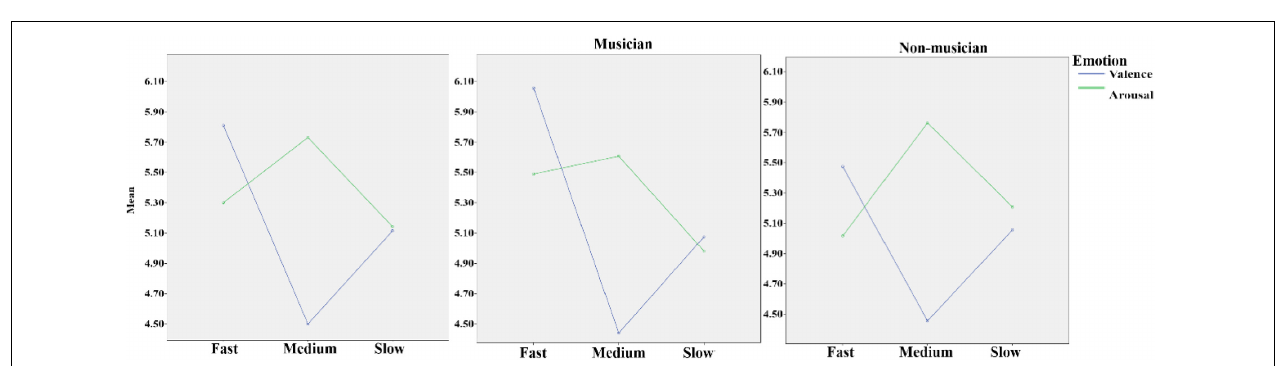
FIGURE 2 | The panel (Left) shows the mean scores of musicians’ and non-musicians’ emotional responses to fast, medium, and slow music. The panel (Middle) shows the valence scores of musicians’ and non-musicians’ emotional responses to fast, medium, and slow music. The panel (Right) shows the arousal scores of musicians’ and non-musicians’ emotional responses to fast, medium, and slow music.